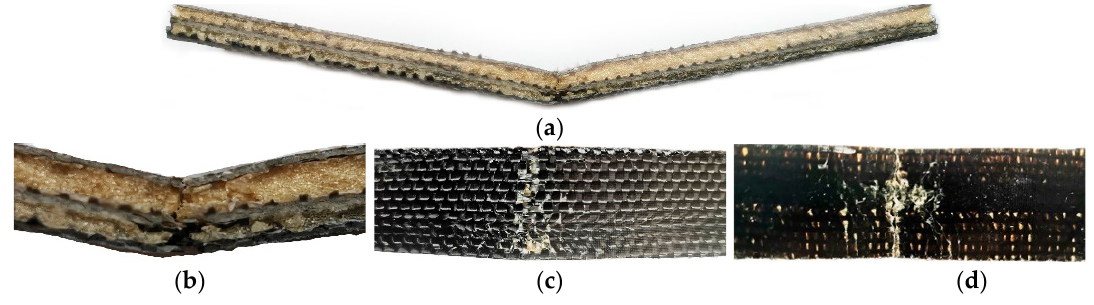
Figure 10. ( a ) Overall view of S2; ( b ) partial side view of S2; ( c ) partial bottom view of S2; ( d ) partial top view of S2.